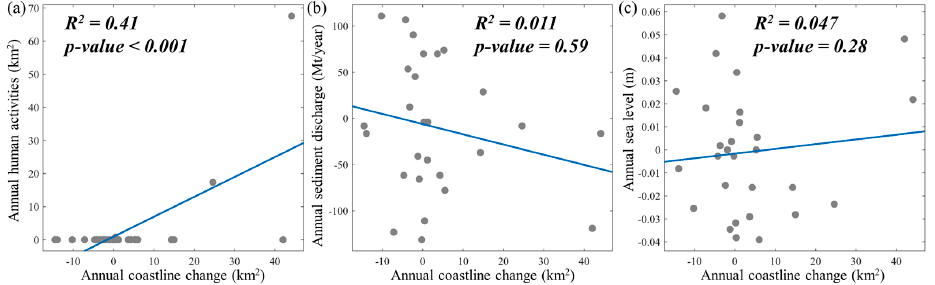
Figure 13. In fl uencing factors analysis. ( a ) Annual human activities; ( b ) Annual sediment discharge; ( c ) Annual sea level.